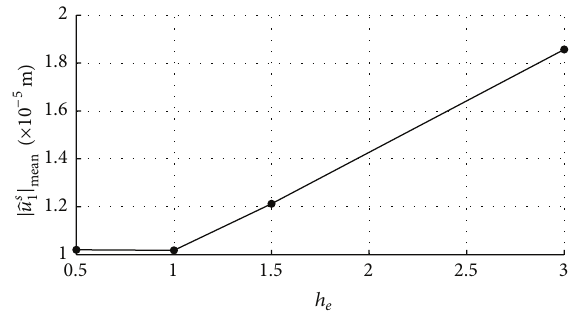
Figure 13: Values of |̂𝑢 𝑠 1 |